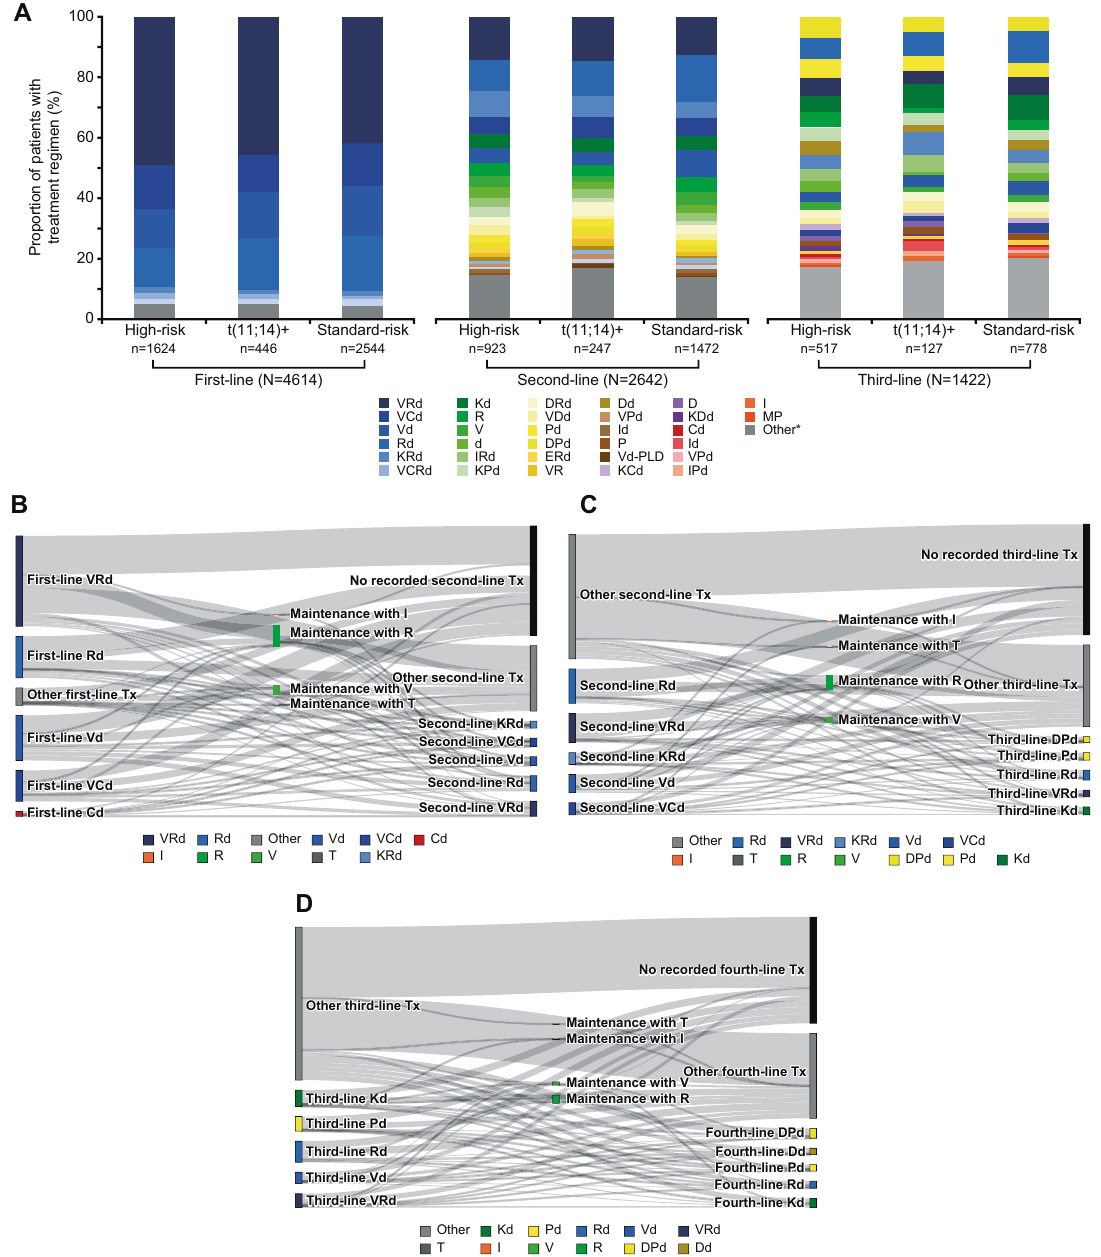
Fig. 2 Treatment patterns per line of treatment. Proportion of patients with treatment regimen by risk subgroup ( A ), and Sankey plots showing treatment patterns for fi rst-line ( B ), second-line ( C ), and third-line ( D ) treatment. An asterisk symbol represents all other therapies, where < 1% of patients receive a particular treatment regimen. The overall number across each line of therapy includes those patients with undocumented risk who were not included in the analyses. Therefore, the N indicated here is the sum of the t (11;14) + , high-risk and standard- risk subgroups, so does not equal the total number of patients. C cyclophosphamide, d dexamethasone, D daratumumab, E elotuzumab, I ixazomib, K car fi lzomib, M melphalan, P pomalidomide, PLD pegylated liposomal doxorubicin, R lenalidomide, t translocation, V